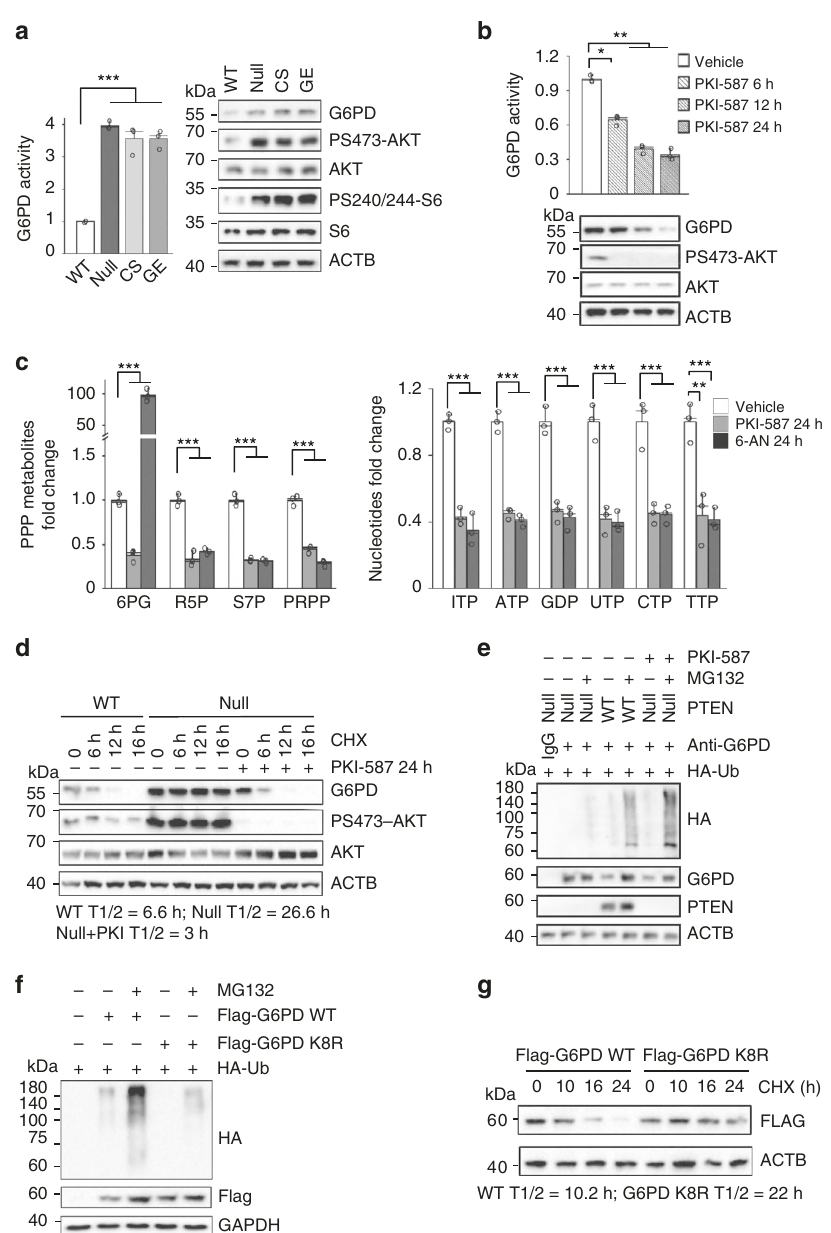
Fig. 2 PI3K/AKT activation promotes PPP by stabilizing G6PD. a, b The enzymatic activities and protein levels of G6PD were increased in the Pten null, CS and GE mES cells compared with the WT cells, and decreased after PKI-587 (1 µ M) treatment in the Pten null mES cells. c PPP metabolites and nucleotide production were decreased by PKI-587 or 6-AN treatment. The Pten null mES cells were switched to medium containing [U- 13 C] glucose and continuously cultured for 12 h, with or without PKI-587 (1 µ M) or 6-AN (100 nM) for the indicated time periods. d The half-lives of G6PD in the Pten WT and null mES cells were measured after PKI-587 (1 µ M) or vehicle treatment for 24 h, or treatment with CHX (100 µ g/ml) for the indicated time periods. e PTEN controls ubiquitination-mediated degradation of the endogenous G6PD. PTEN WT and null HEK293T cells were transfected with the HA-Ubiquitin expression plasmids. Twenty-four hours later, cells were incubated with or without MG132 (5 μ M) or PKI-587 (1 µ M) for 24 h. Total cell lysates were immunoprecipitated with an anti-G6PD antibody. f HEK293T cells were cotransfected with the HA-ubiquitin , Flag-G6PD WT or Flag-G6PD K8R expression plasmids. Twenty-four hours later, the cells were incubated with or without MG132 (5 µ M) for 16 h. Total cell lysates were harvested, immunoprecipitated with a Flag antibody. g The half-lives of exogenous WT and K8R G6PD were measured after CHX (100 µ g/ml) treatment for the indicated time periods. Data are presented as the mean ± SD and compared with the WT or untreated cells. n = 3, each experiment was performed four independent times. * p < 0.05, ** p < 0.001, and *** p < 0.001, based on Student ’ s t test (two-sided ANOVA). See also Supplementary Fig. 2 and Supplementary Table 1. Source data are provided as a Source Data fi